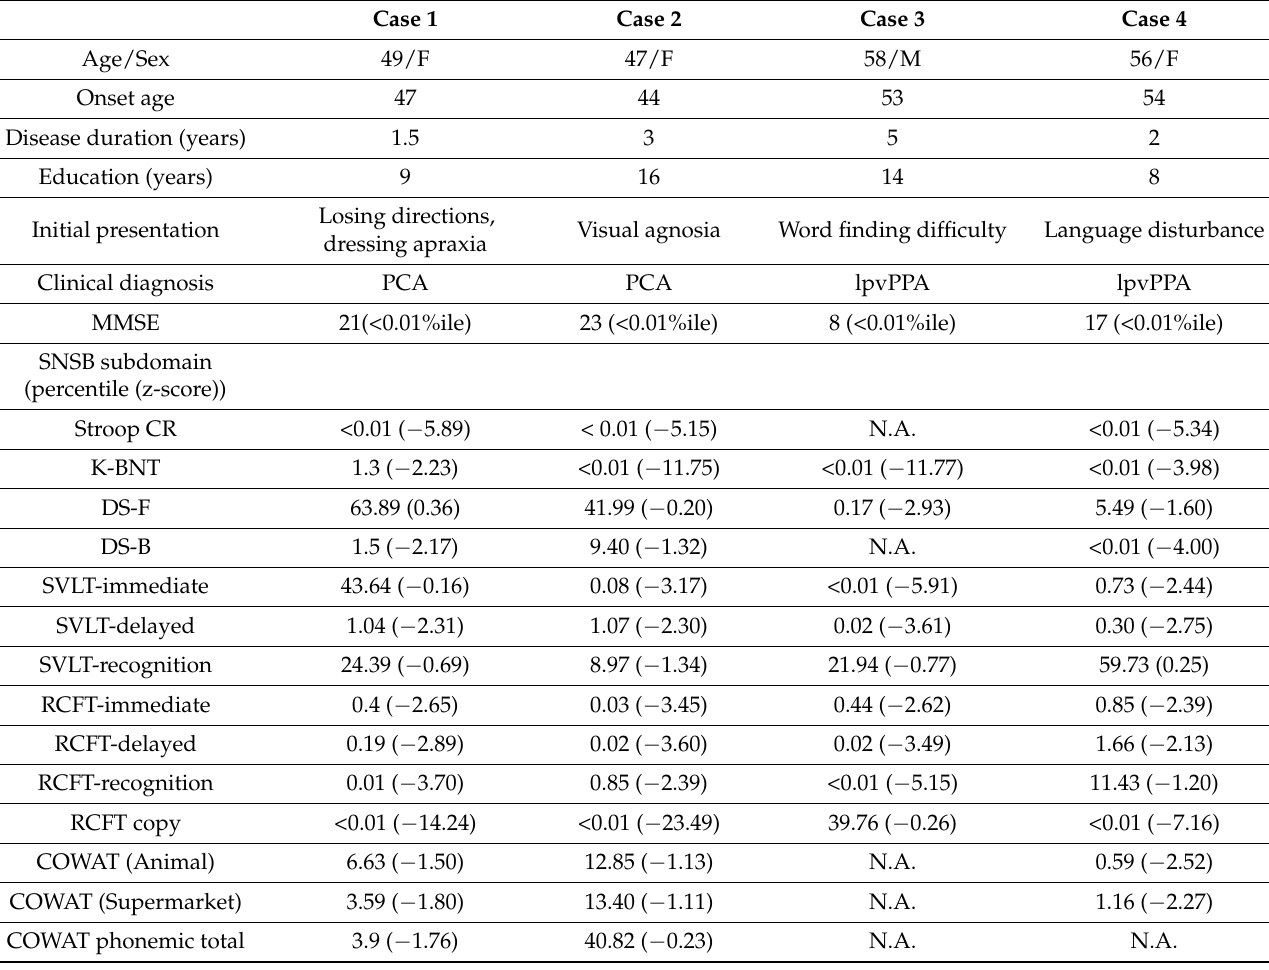
Table 1. Demographic and neuropsychological